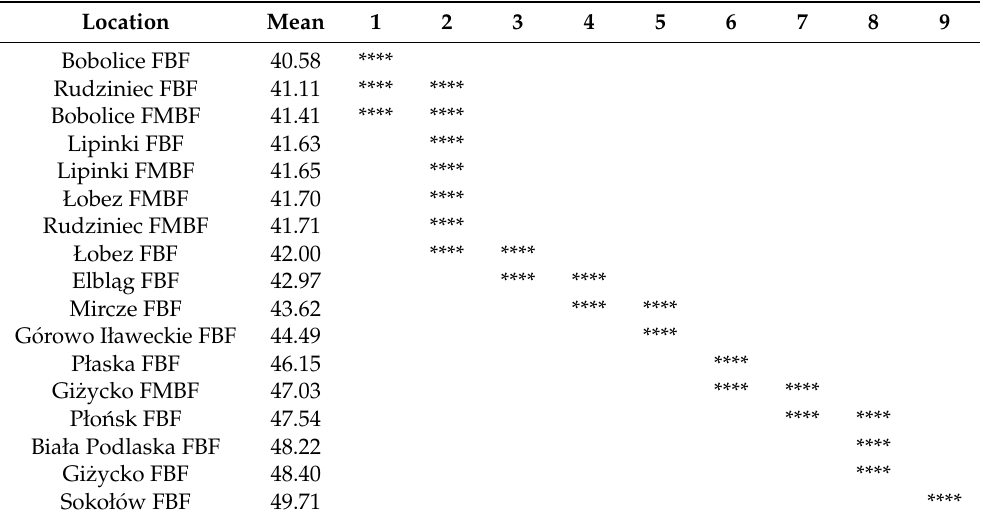
Table 8. Homogeneous groups of locations in terms of mean wood hardness (HSD Tukey’s range test).